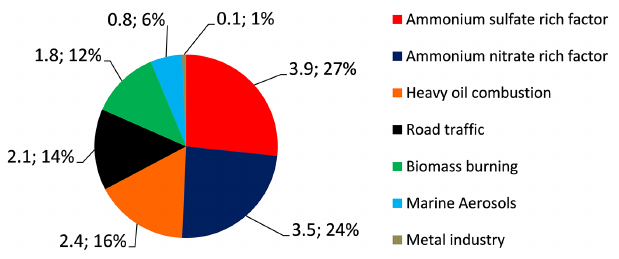
Figure 6. Annual average contribution (µgm − 3 ; %) to PM 2 . 5 mass (14.7µgm − 3 ) of the seven sources, from 11 September 2009 to 10 September